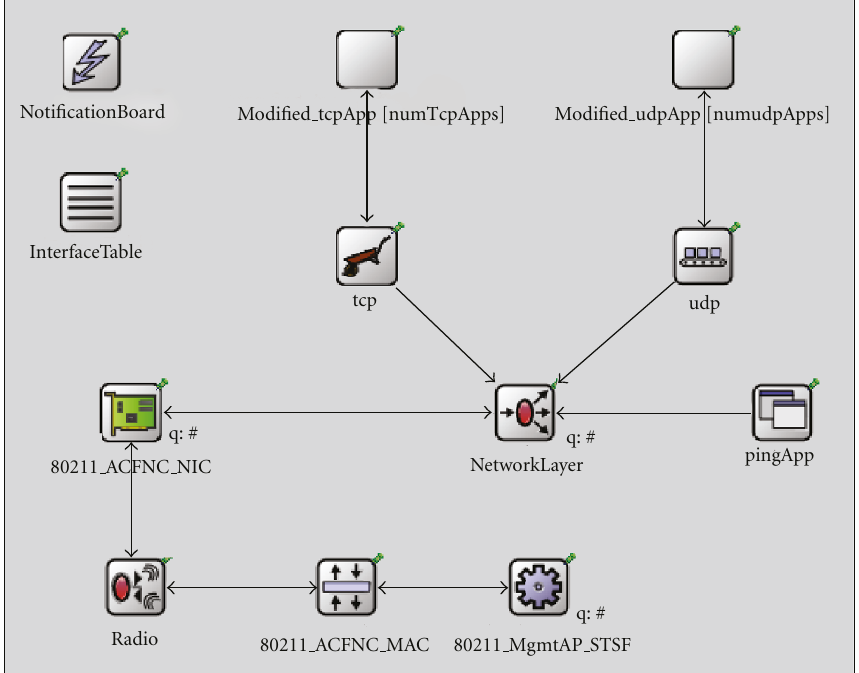
Figure 5: Structure of the protected 80211-ACFNC-NIC in the simulation environment